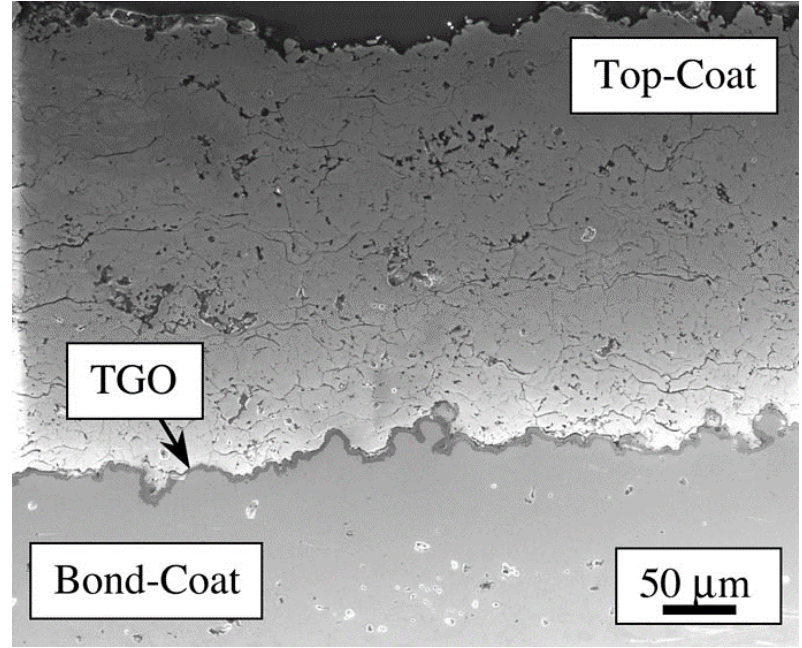
Figure 13. Cross-sectional SEM of an air-plasma sprayed (APS) TBC that has been subjected to 120 thermal cycles (reproduced with permission from [58], The American Association for the Advancement of Science, 2002).